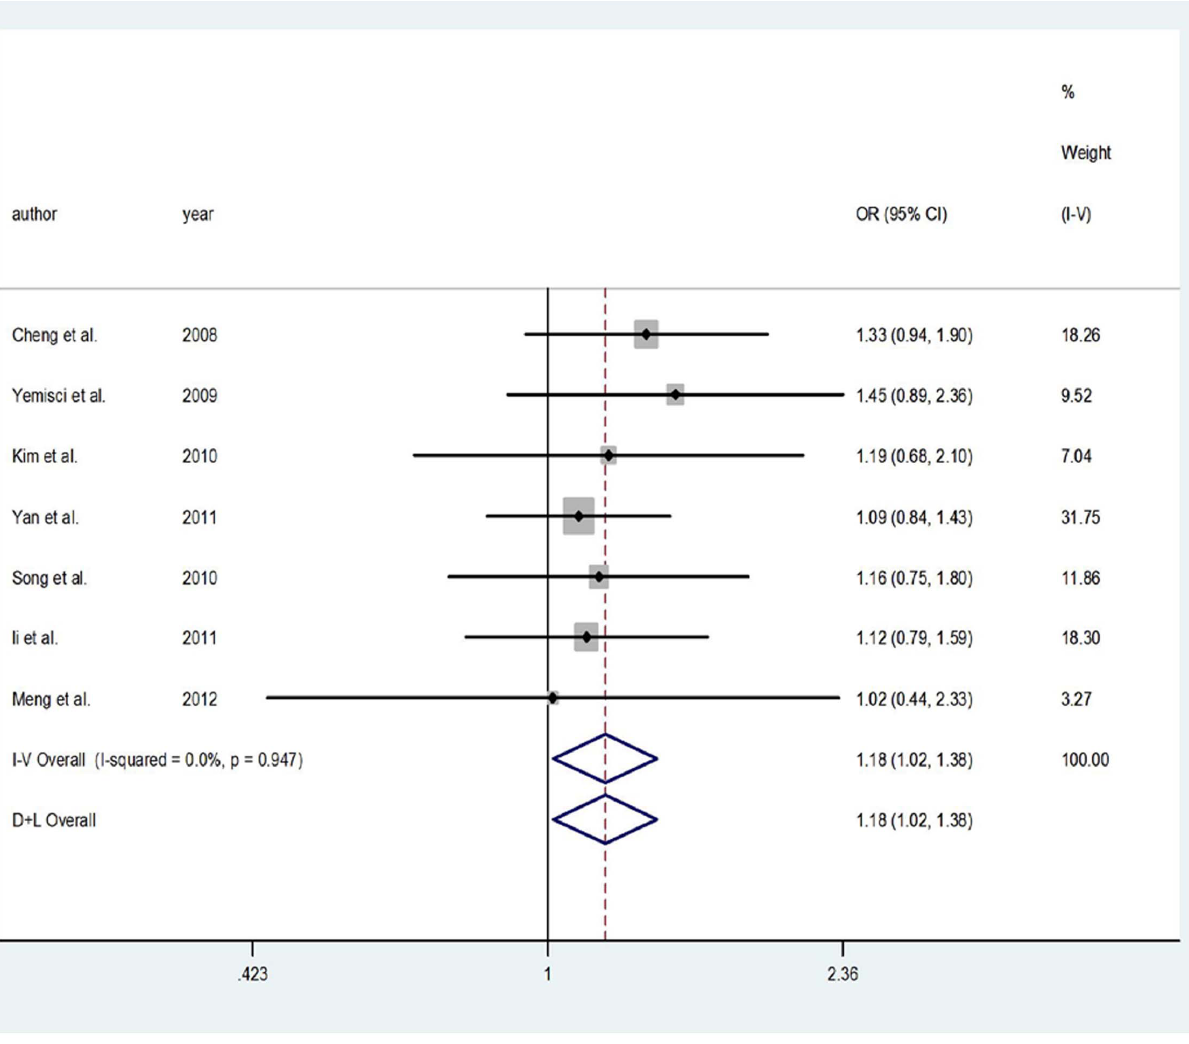
Figure 3. Meta-analysis for IS risk depending on the T-786C polymorphism in the eNOS gene. Forest plots of relationship between eNOS gene T-786C polymorphism and IS risk in codominant model in Asian. White diamond denotes the pooled OR. Black squares indicate the OR in each study, with square sizes inversely proportional to the standard error of the OR. Horizontal lines represent 95% CIs.